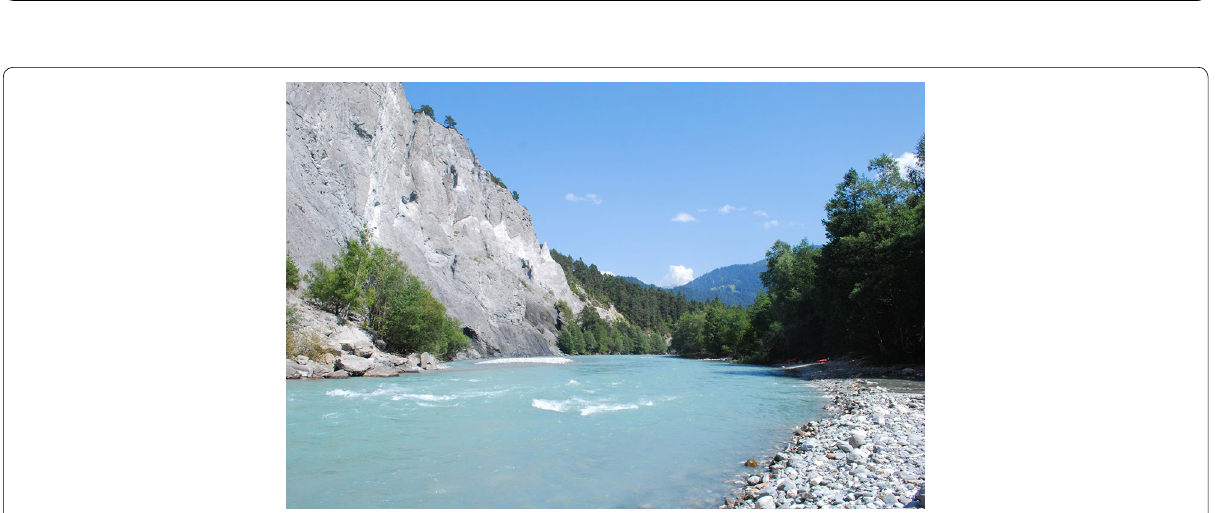
Fig. 8 Anterior Rhine in the Ruinaulta in canton Grisons,